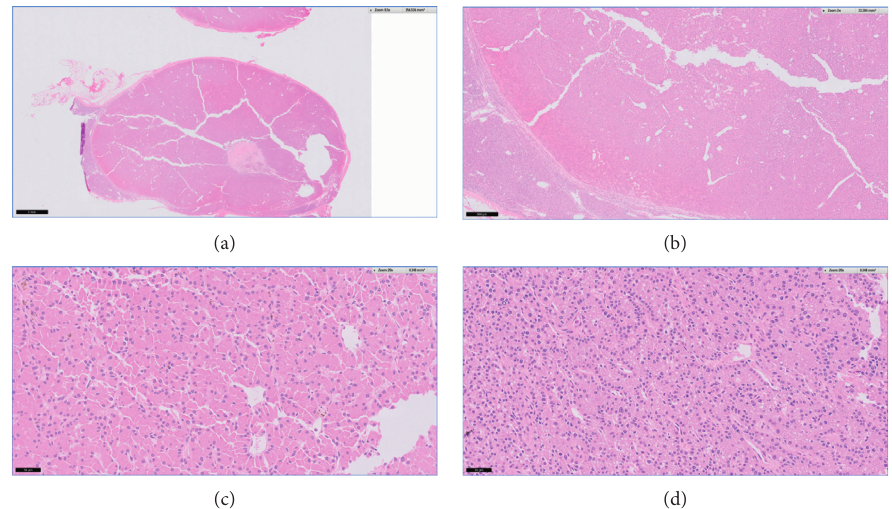
Figure 5: Section showing nodular proliferation of chief cells and oxyphilic cells. The component cells show a palisaded arrangement around blood vessels. (a) Low power. (b) Medium power. (c) High power (H&E, × 20): oxyphilic cells show round-to-ovoid nuclei with abundant granular eosinophilic cytoplasm. (d) Chief cells (H&E, × 20): chief cells show round nuclei and amphophilic cytoplasm. No nuclear pleomorphism or increased mitotic activity is seen. Table 2: Genomic DNA isolation and mutation screening, DNA extraction, and amplification of PHEX exons by PCR. PCR thermocycling conditions for amplifying the Forward and reverse primer sequences for screening exon 14 PHEX gene